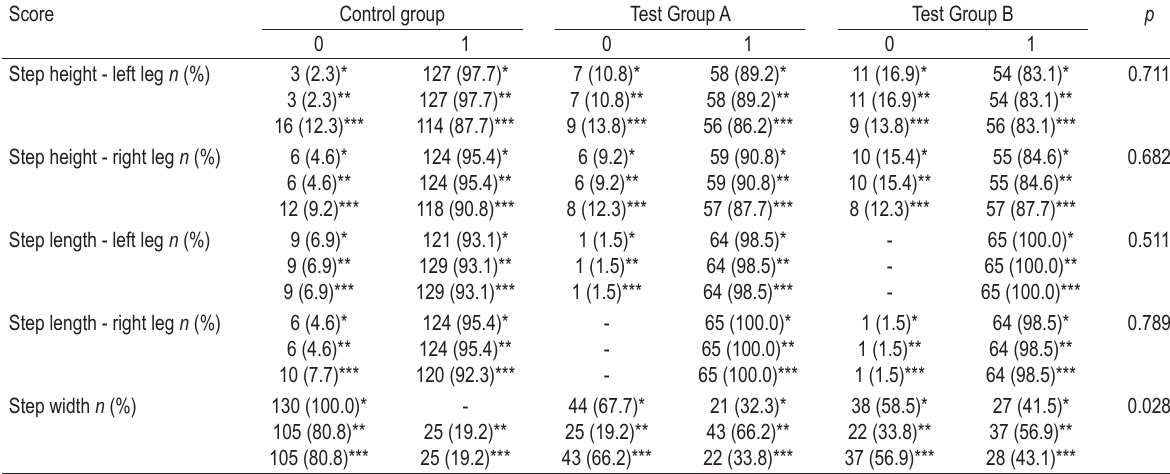
TABLE 4. Comparison of the gait elements values through three measurements in relation to the examined groups ‑ POMA G (Part I) Score